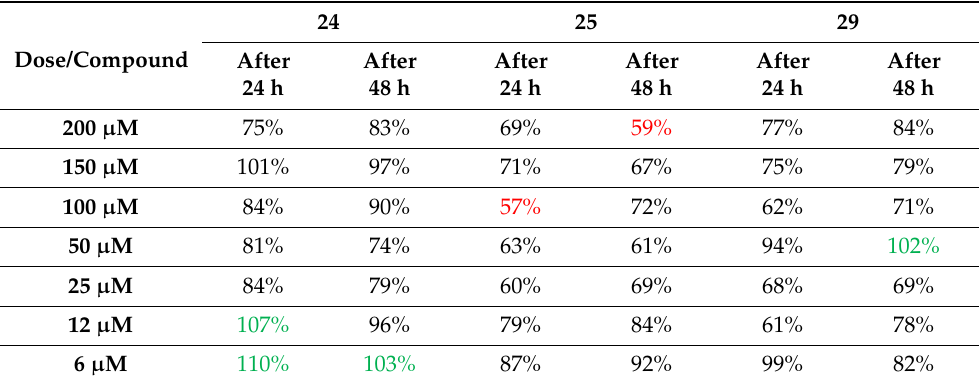
Table 2. The cell proliferation in % according to control after 24 and 48 h exposition on studied compounds in L929 cell line.